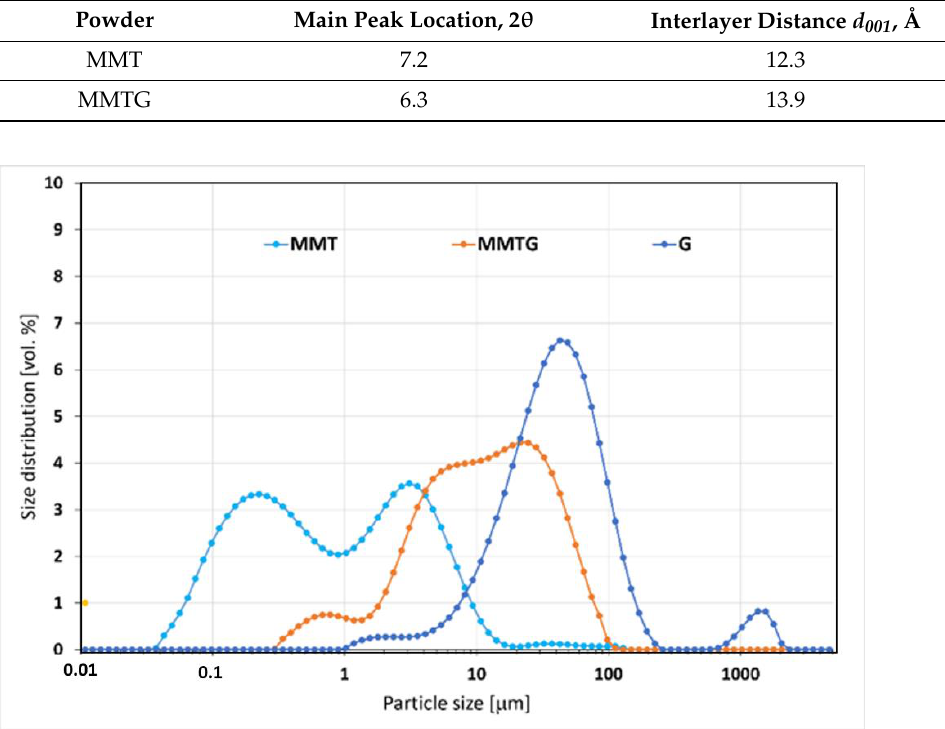
Figure 2. Grain size distribution of MMT, G and MMTG powders.